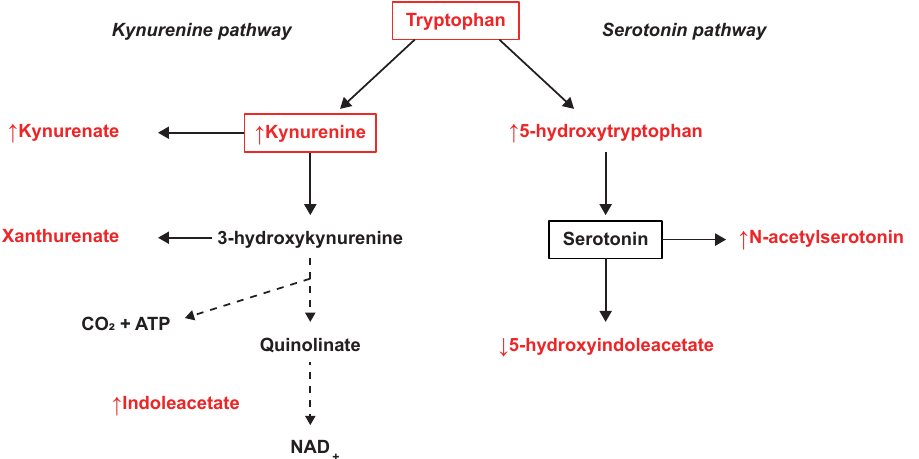
Figure 4. Tryptophan metabolism and the observed changes in the kynurenine and serotonin pathways. The metabolites marked in red were identified and measured, where ↑ illustrates an averaged increase and ↓ an averaged decrease in SPMS